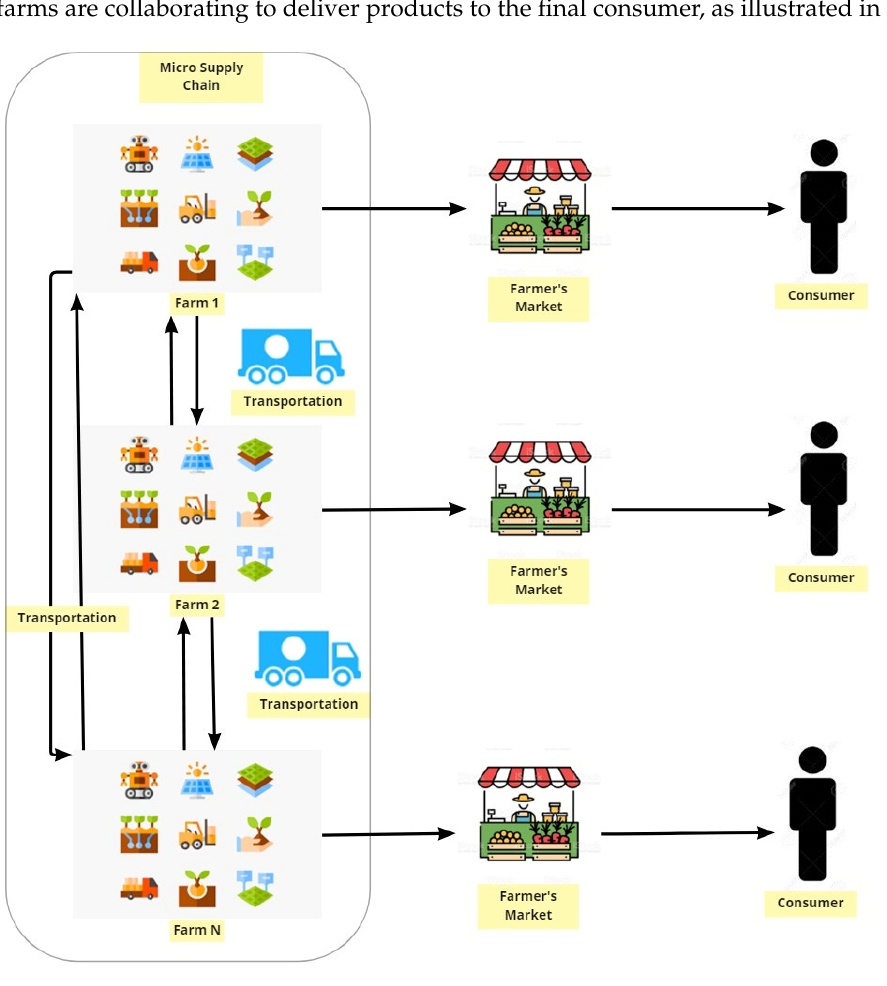
Figure 6. Micro supply chain illustrating the farm-to-farm exchange.